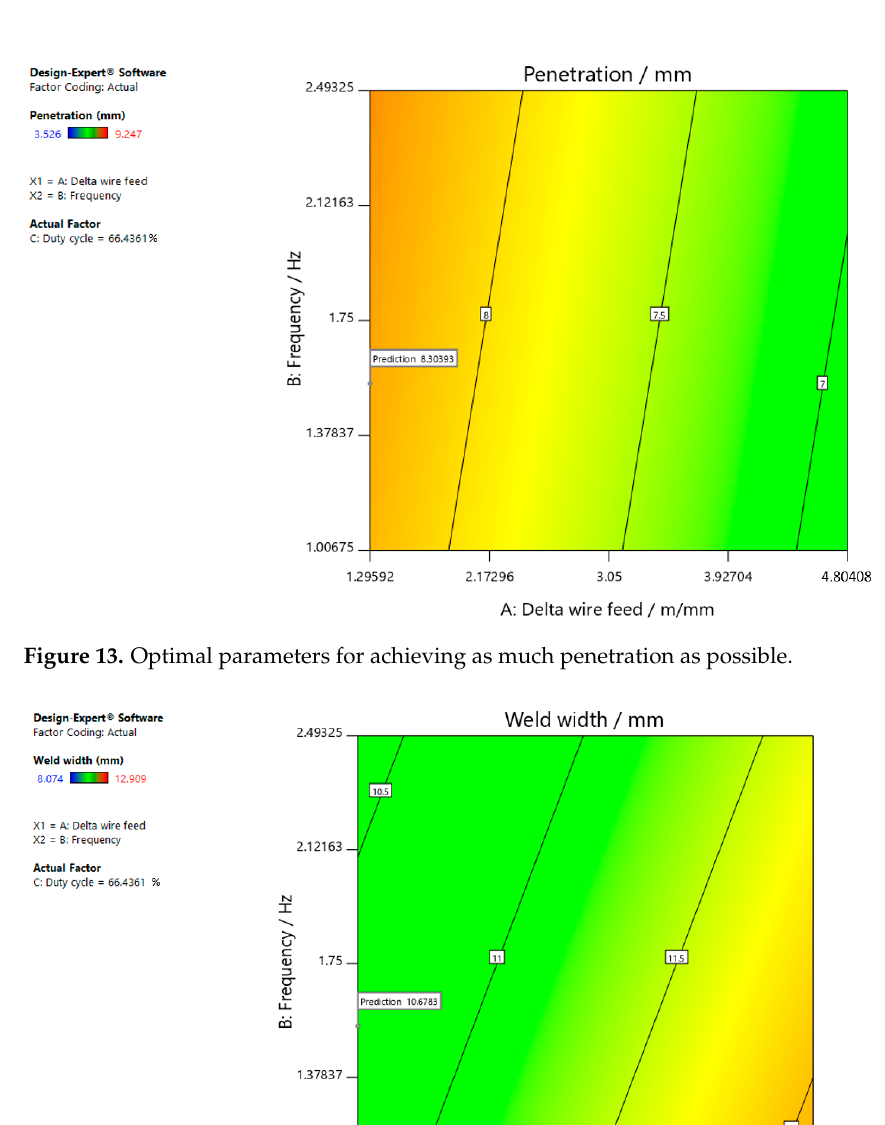
Figure 12. Optimal parameters for achieving the insufficient/excessive throat thickness with a target value of 0.